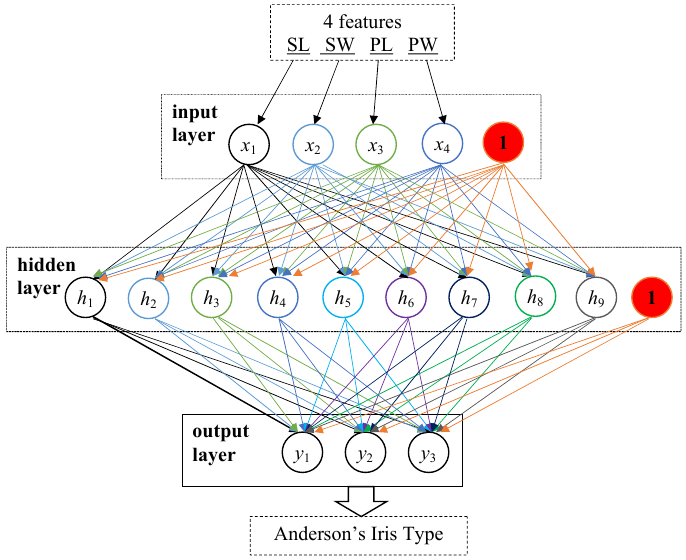
Fig. 1. Architecture of the neural network to solve the problem of Anderson’s Iris